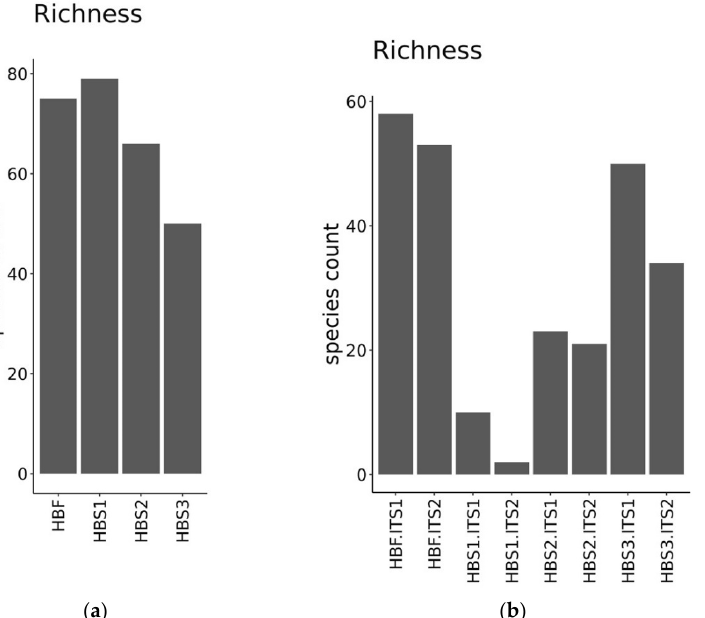
Figure 4. Richness plot ( a ) shows richness of bacteria in hull-less barley flour (HBF) and in hull-less barley sourdough at the end of the 1st backslopping step (HBS1), 2nd backslopping step (HBS2) and 3rd backslopping step (HBS3) of fermentation. Plot ( b ) shows the richness of fungi in hull-less barley flour (HBF.ITS1; HBF.ITS2) and in hull-less barley sourdough at the end of the 1st backslopping step (HBS1.ITS1; HBS1.ITS2); 2nd backslopping step (HBS2.ITS1; HBS2.ITS2) and 3rd backslopping step (HBS3.ITS1; HBS3.ITS2) of fermentation.